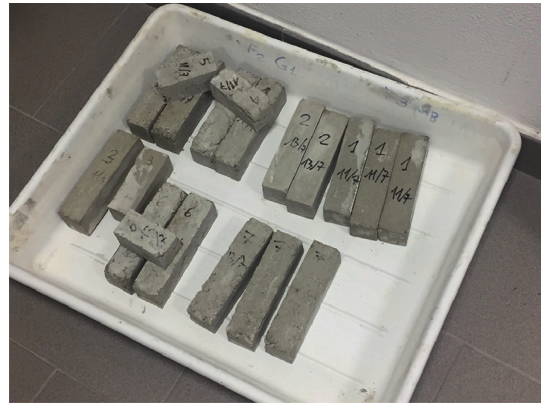
Figure 3: DPET-prismatic samples tested to flexural load.